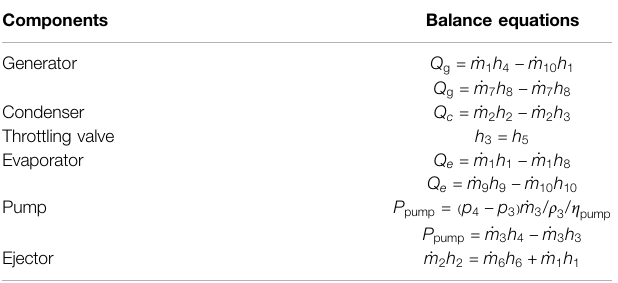
TABLE 2 | Baseline working condition for analysis.